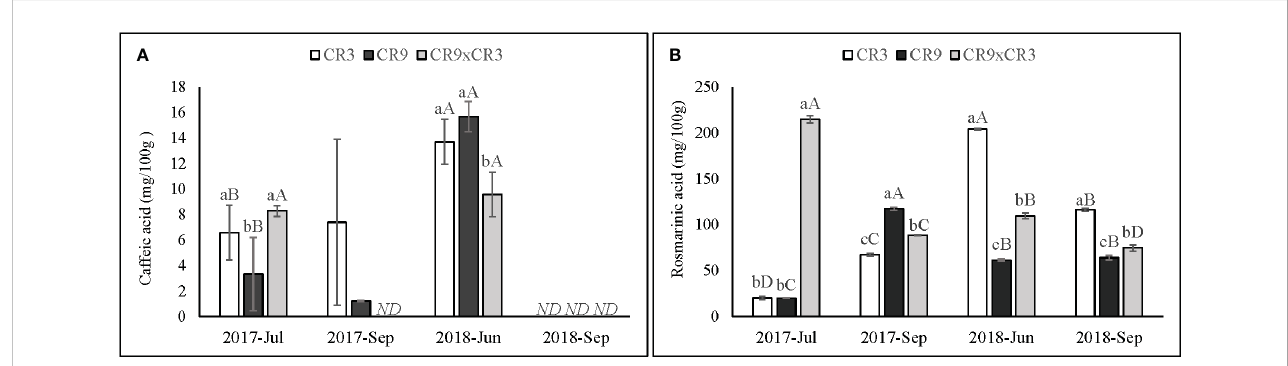
FIGURE 6 Content of caffeic acid (A) and rosmarinic acid (B) in catnip genotypes at different harvest times. Pittstown, NJ, United States Vertical error bars indicate standard deviation. Uppercase letters indicate statistical comparisons of the same genotype across harvests and lowercase letters indicate comparisons among the three genotypes inside the same harvest. Averages with different letters are statistically different by the Scott-Knott test ( p = ≤ 0.01). ND , not detected. Because caffeic acid was not detected in any of the genotypes for plants harvested in September 2018 and in genotype CR9×CR3 for plants harvested in September 2017, those harvests have not been included in the statistical analysis.